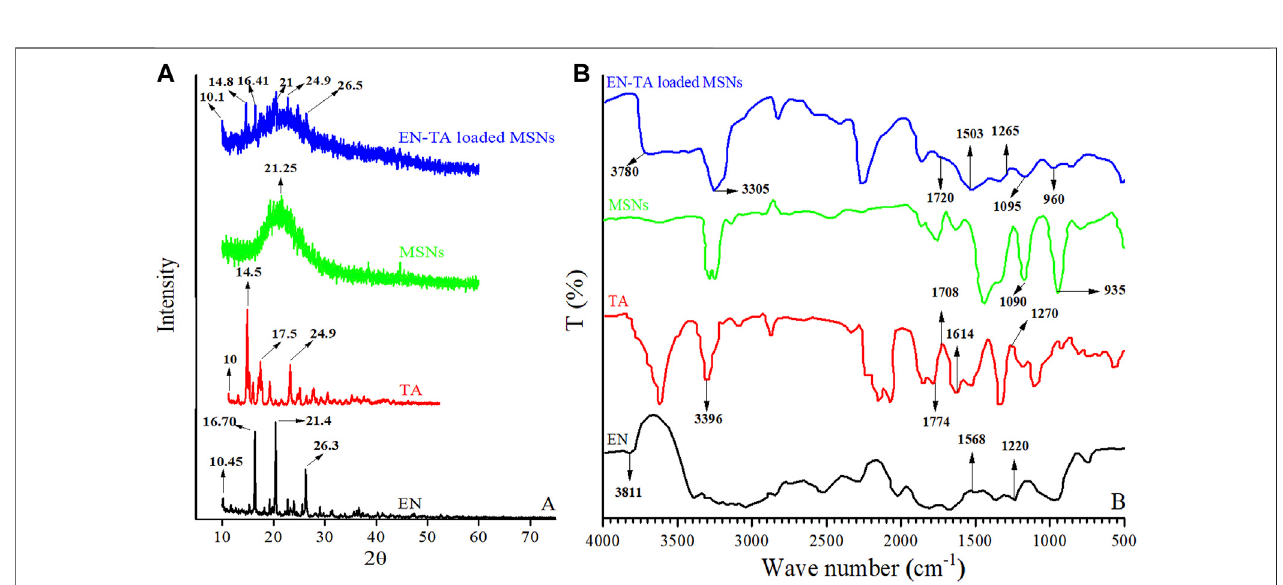
FIGURE 2 | (A) XRD and (B) FTIR spectra of econazole nitrate (EN), triamcinolone acetonide (TA), MSNs, and EN-TA loaded